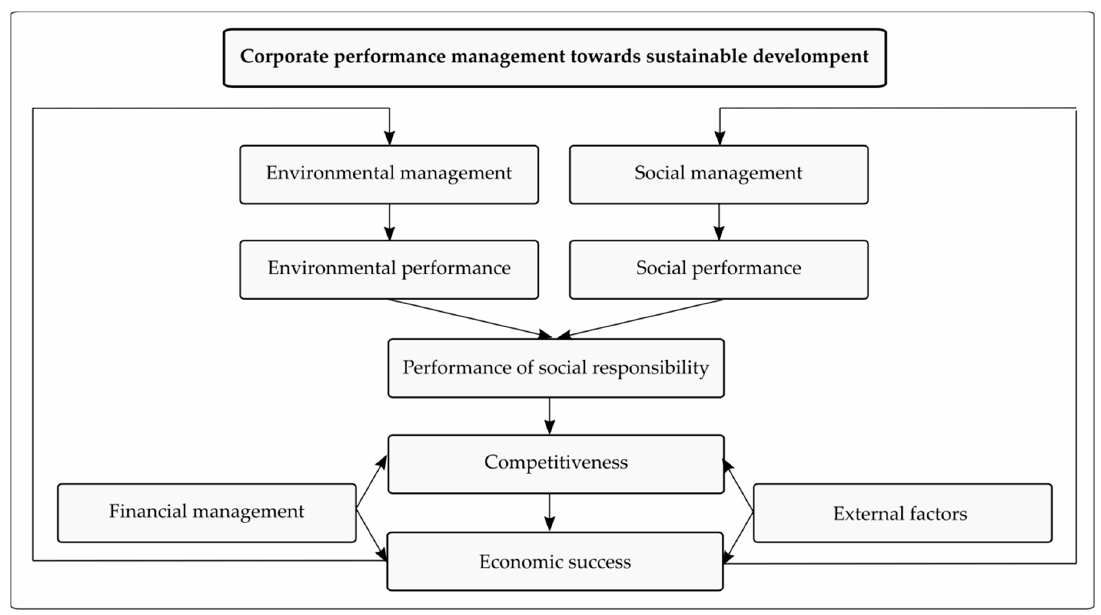
Figure 1. The impact of performance on economic success in sustainable management. Source: our processing according to [24].